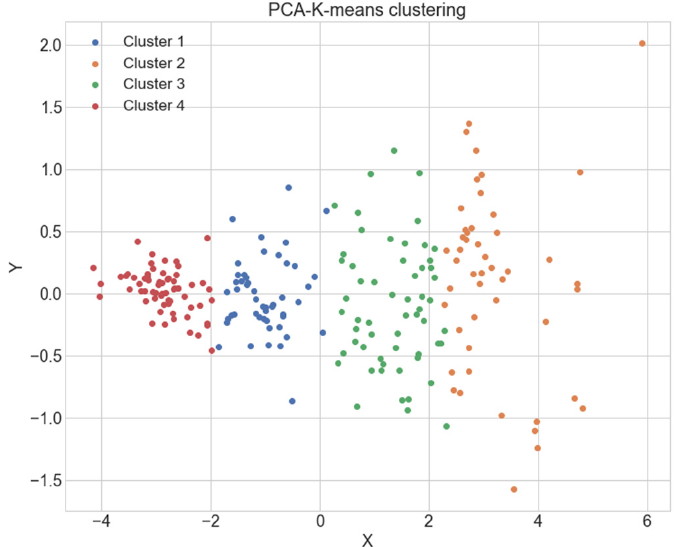
Figure 1. PCA-K-means of the spectra within the fingerprint region. Four clusters are identified by using the elbow method and corroborated the gap statistic. The presence of clusters allows to determine whether the data actually have any possible segregated data.